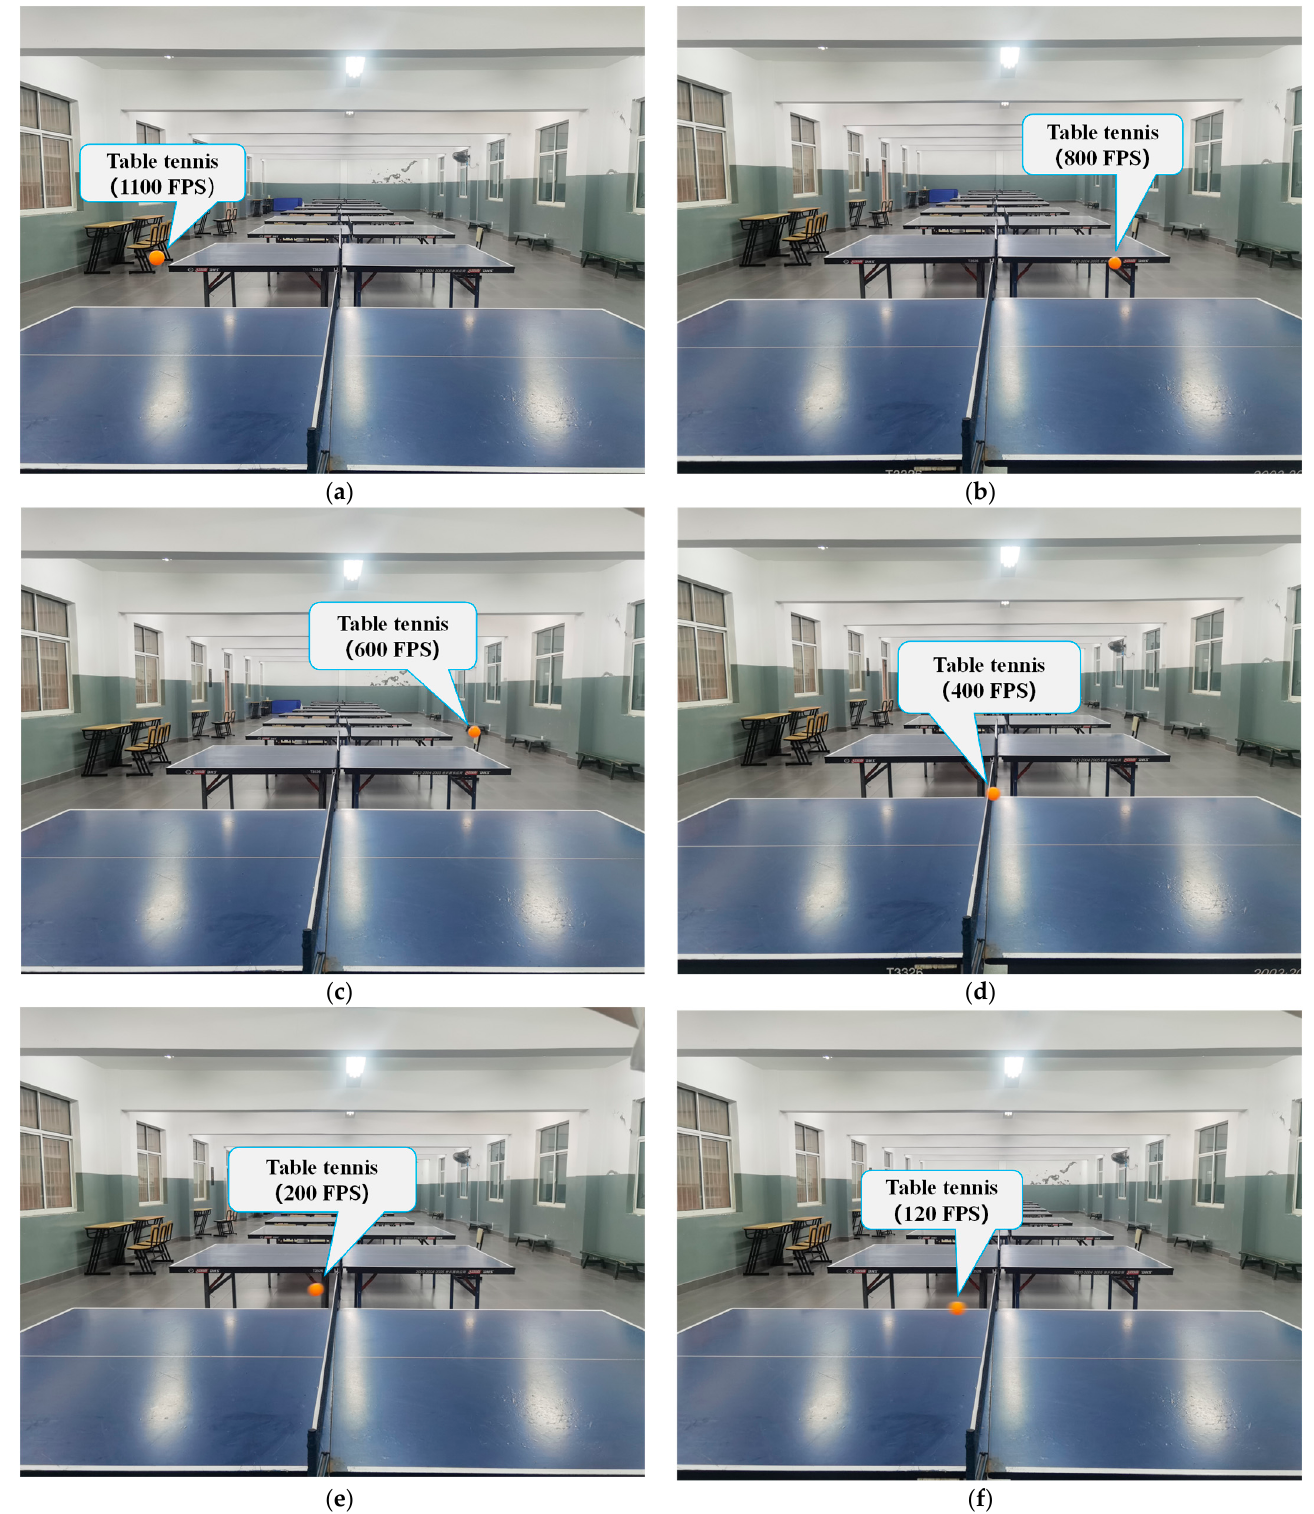
Figure 1. Sample image frames: ( a ) 1100 FPS, ( b ) 800 FPS, ( c ) 600 FPS, ( d ) 400 FPS, ( e ) 200 FPS, ( f ) 120 FPS.